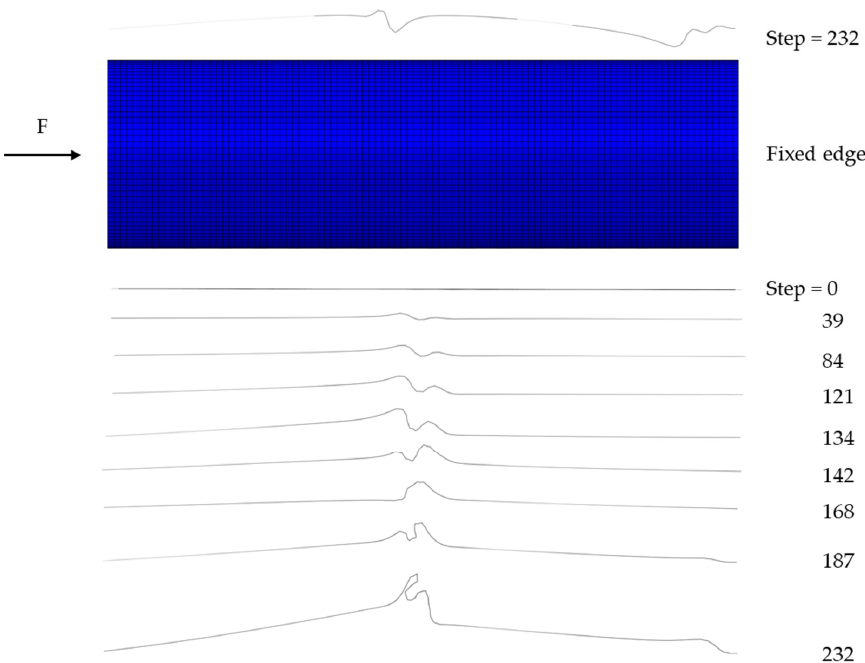
Figure 13. Shell (20 m at 24 mm) longitudinal surface displacement under axial compressive load, (scale factor = 5).